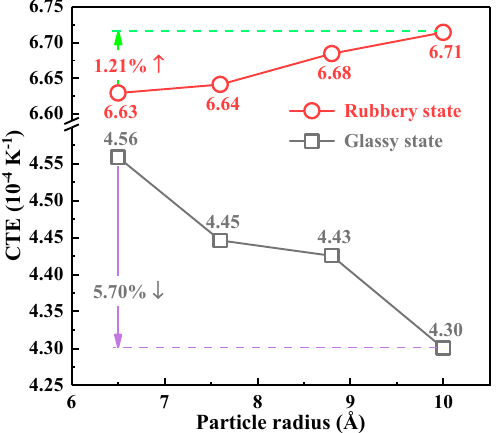
Figure 9. The CTE with different particle sizes under 67% crosslinking density.